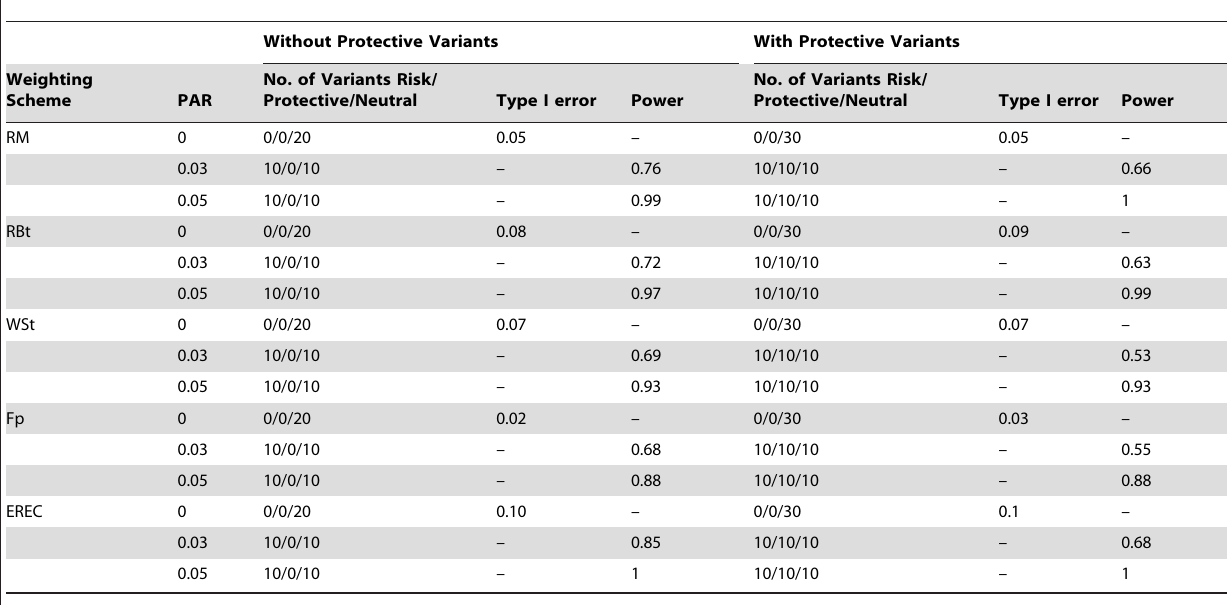
Without Protective Variants